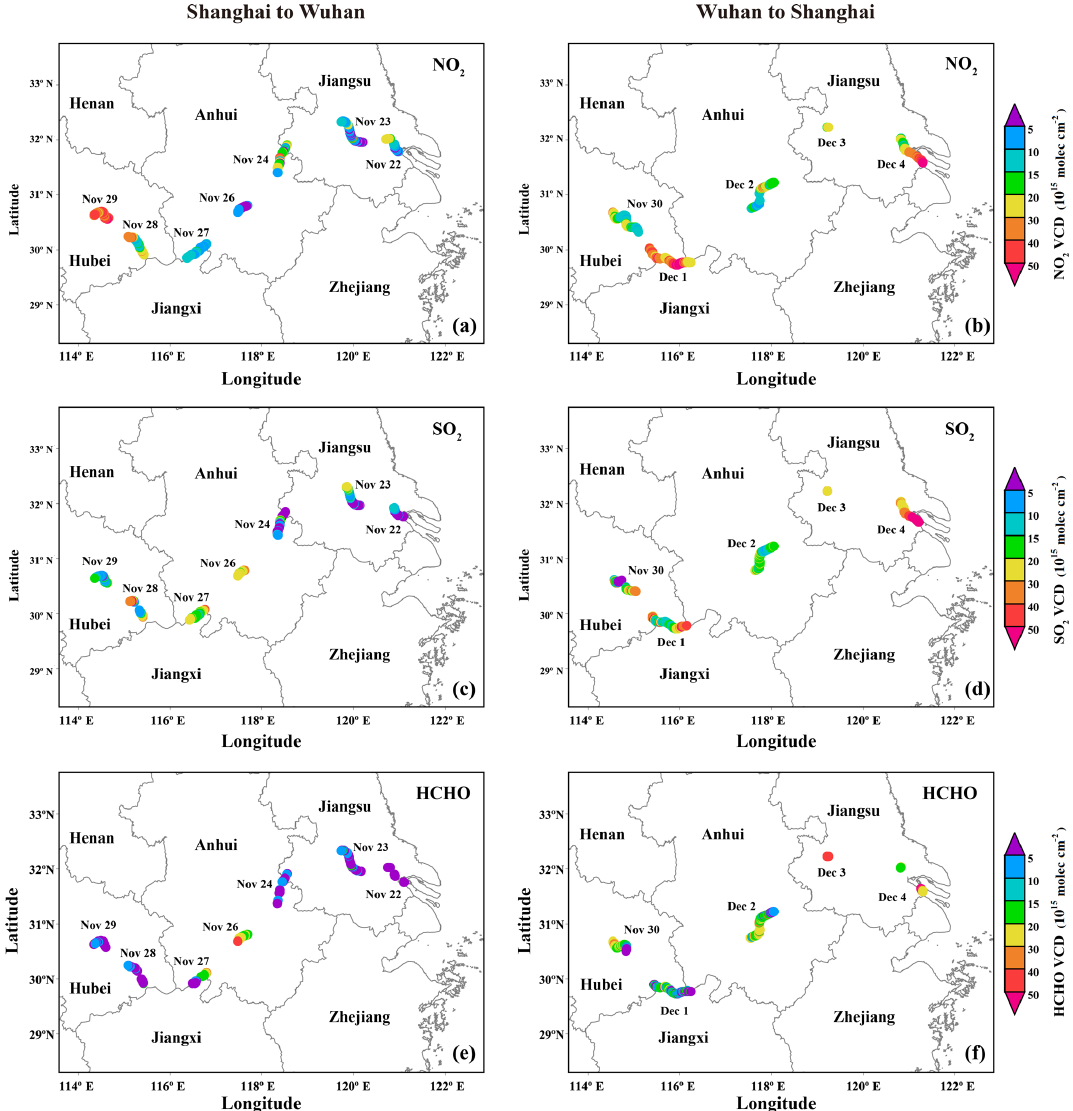
Figure 5. Spatial distribution of tropospheric NO 2 (a, b) , SO 2 (c, d) , and HCHO (e, f) VCDs along the departing route ( a, c, e , from Shanghai to Wuhan) and returning route ( b, d, f , from Wuhan to Shanghai). Note that the ship was anchored at Yizheng Marine department on 3 December